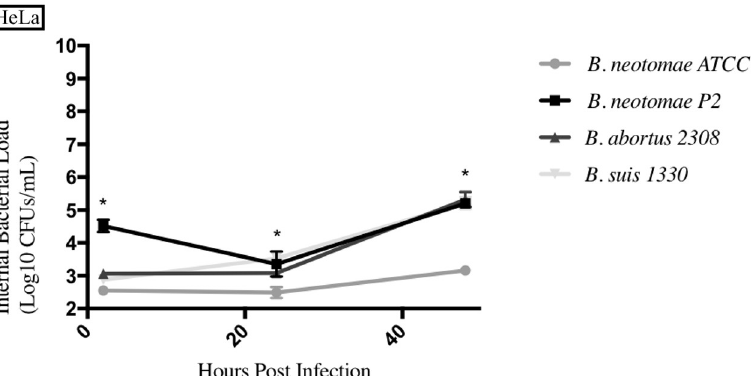
Fig 3. Intracellular survival of Brucella species in the human epithelial cell line (HeLa). Intracellular Brucella spp. bacterial CFUs were determined over 48hrs in HeLa as described. Error bars represent the standard deviation of the triplicates from a single experiment. � represents when intracellular CFUs from more than one species tested statistically differs from BN with any p value lower than 0.05.